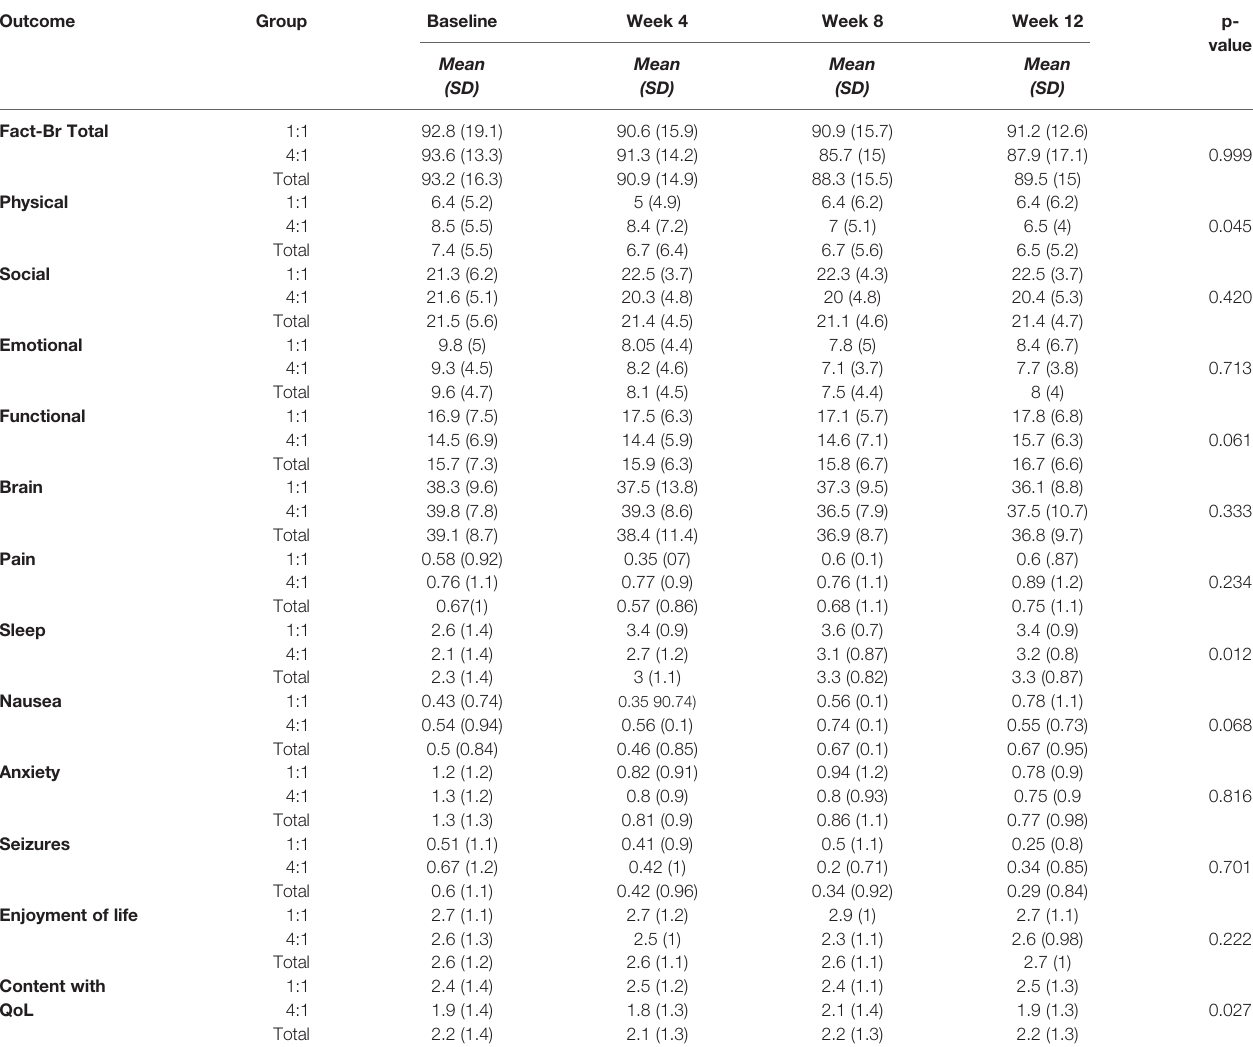
value Mean Mean Mean Mean (SD) (SD) (SD) (SD)